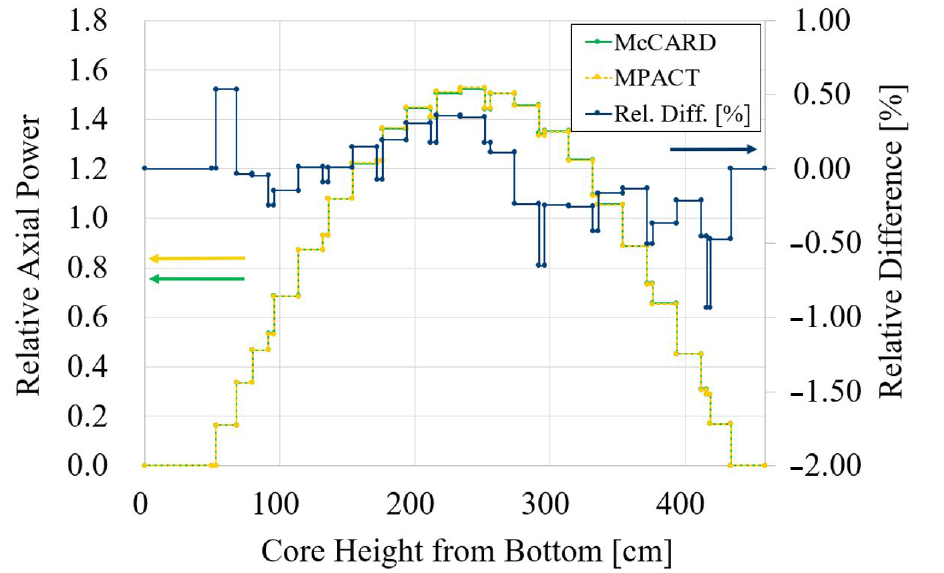
Figure 23. Axial power and relative difference from McCARD for HZ2